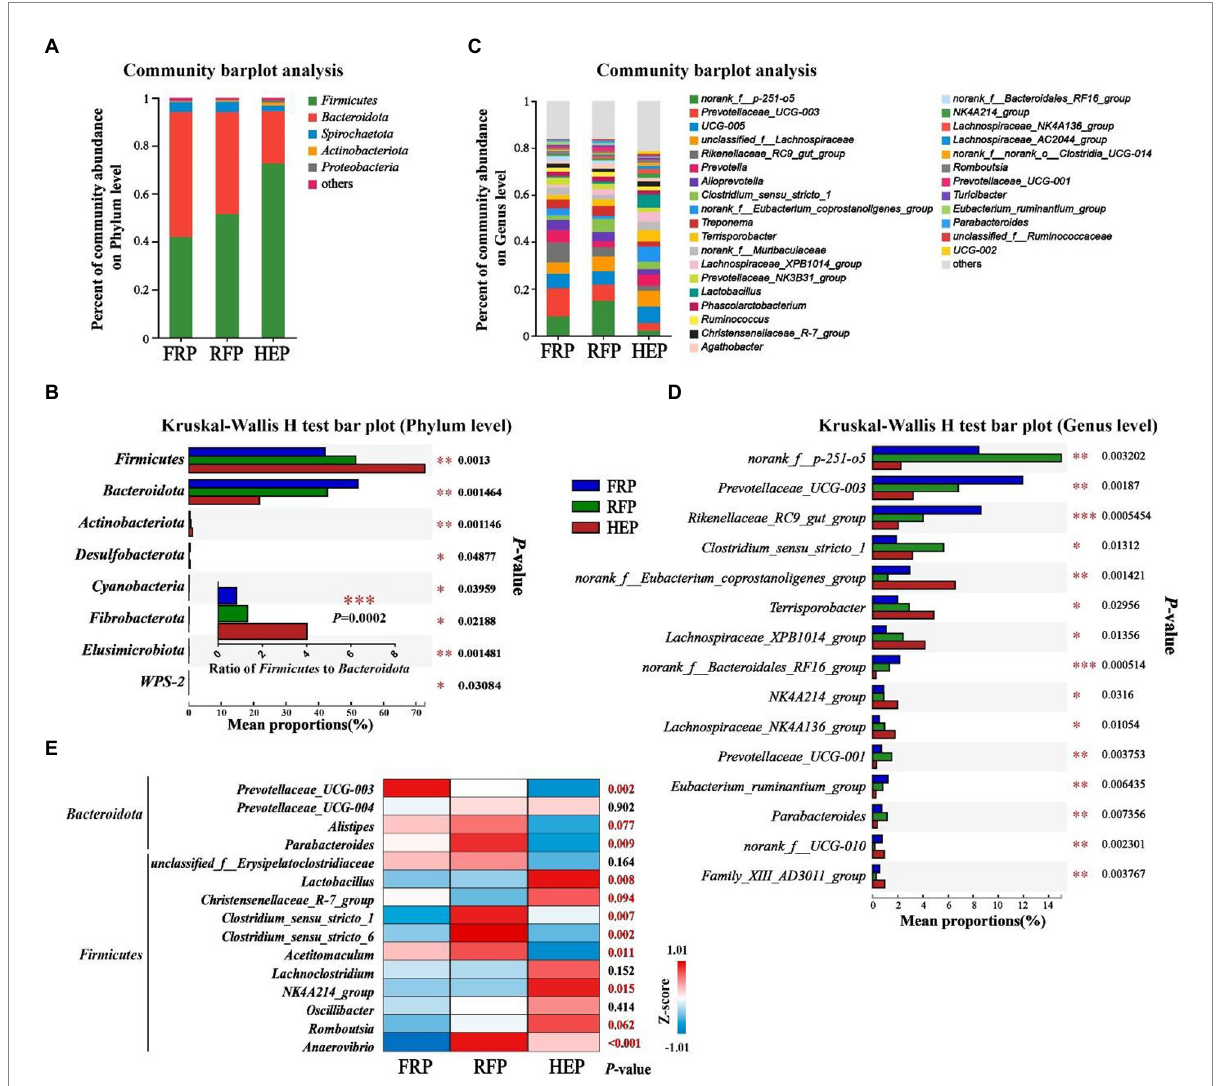
FIGURE 5 Effects of different feeding patterns on gut microbiota community composition in the cecal chyme of Tibetan pigs. The relative abundances of microbiota in cecal chyme at the phylum (A) or genus level (C) . Analysis of variance in the gut microbiota with significant differences at the phylum (B) and genus level (the top 15 genera, D ). (E) heat map of the different enrichment of bacteria related to meat quality among three groups. Data are expressed as mean value ( n = 7). *, ** and *** indicates p <0.05, p <0.01 and p <0.001, respectively. FRP: free-ranging Tibetan pigs; RFP: feeding the regular Tibetan pig diets; HEP: feeding the high energy content